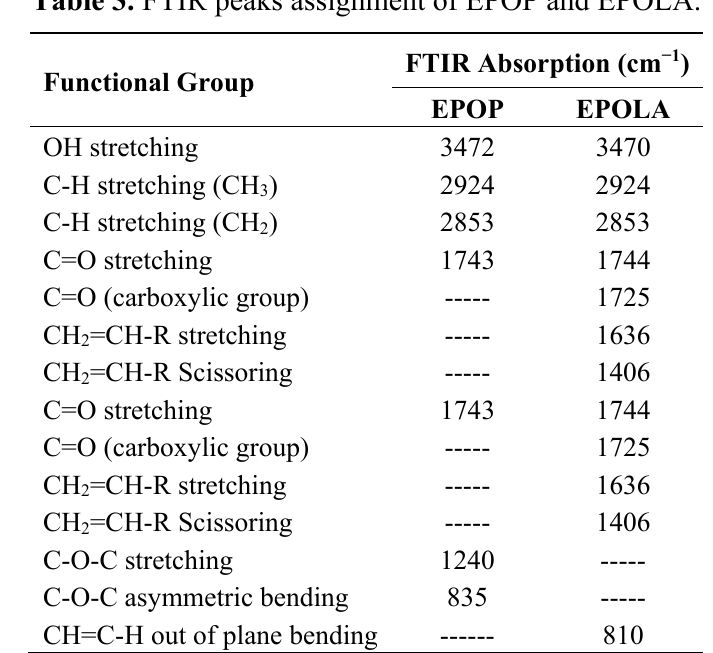
Figure 3. FTIR Spectra of EPOP and EPOLA. Table 3. FTIR peaks assignment of EPOP and